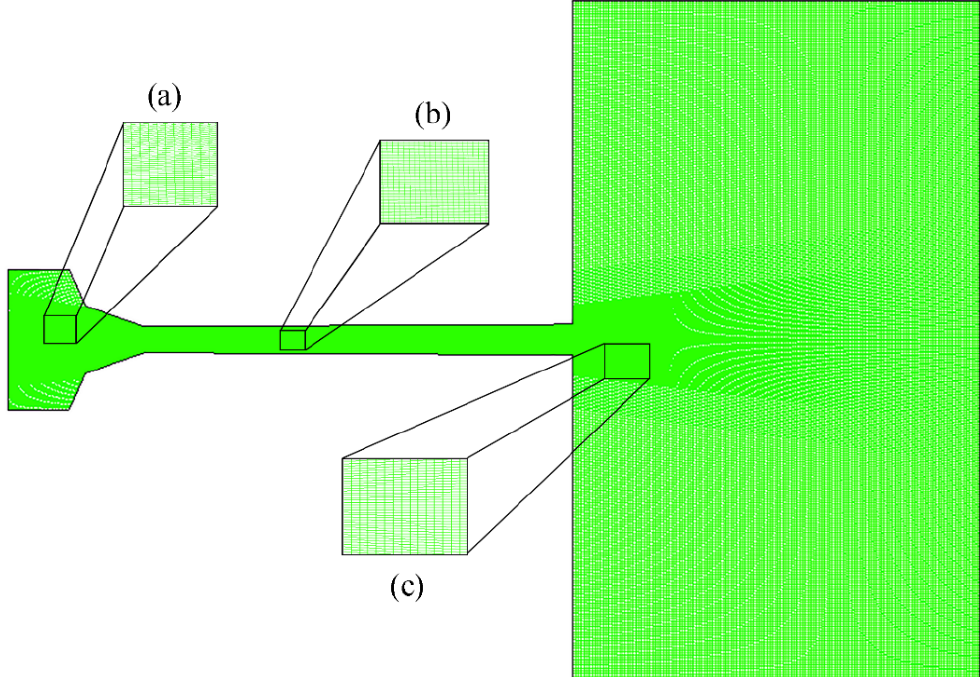
Figure 2. Detailed grid description of the AK07 spray gun: ( a ) combustion chamber, ( b ) Laval nozzle and ( c ) air domain.